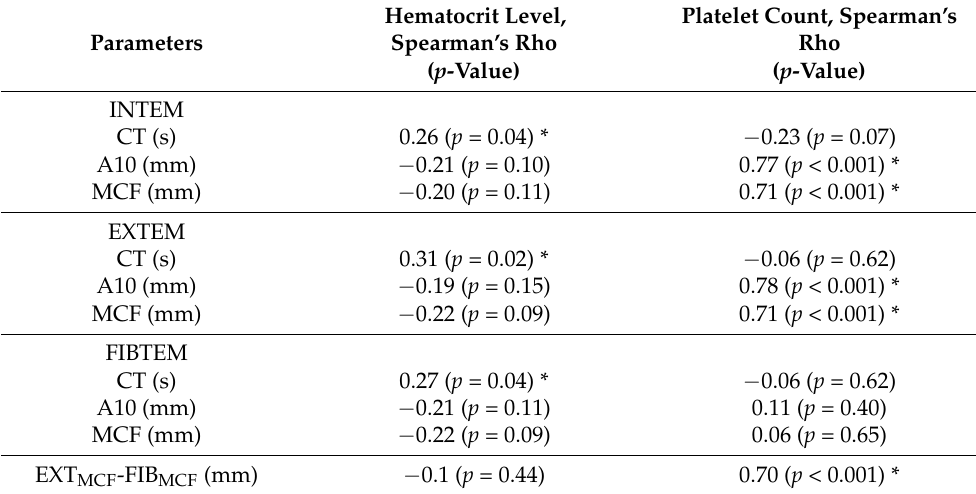
Table 4. Association of “hematocrit increase” and “platelet decrease” during febrile phase with ROTEM and platelet